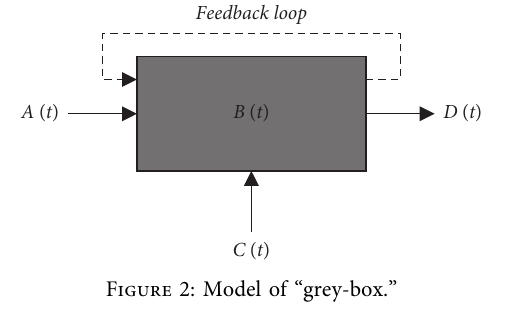
Figure 3: Stages of possible error accumulation.